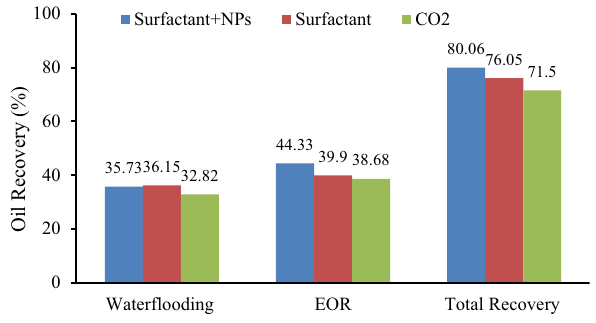
2 and foam injection,